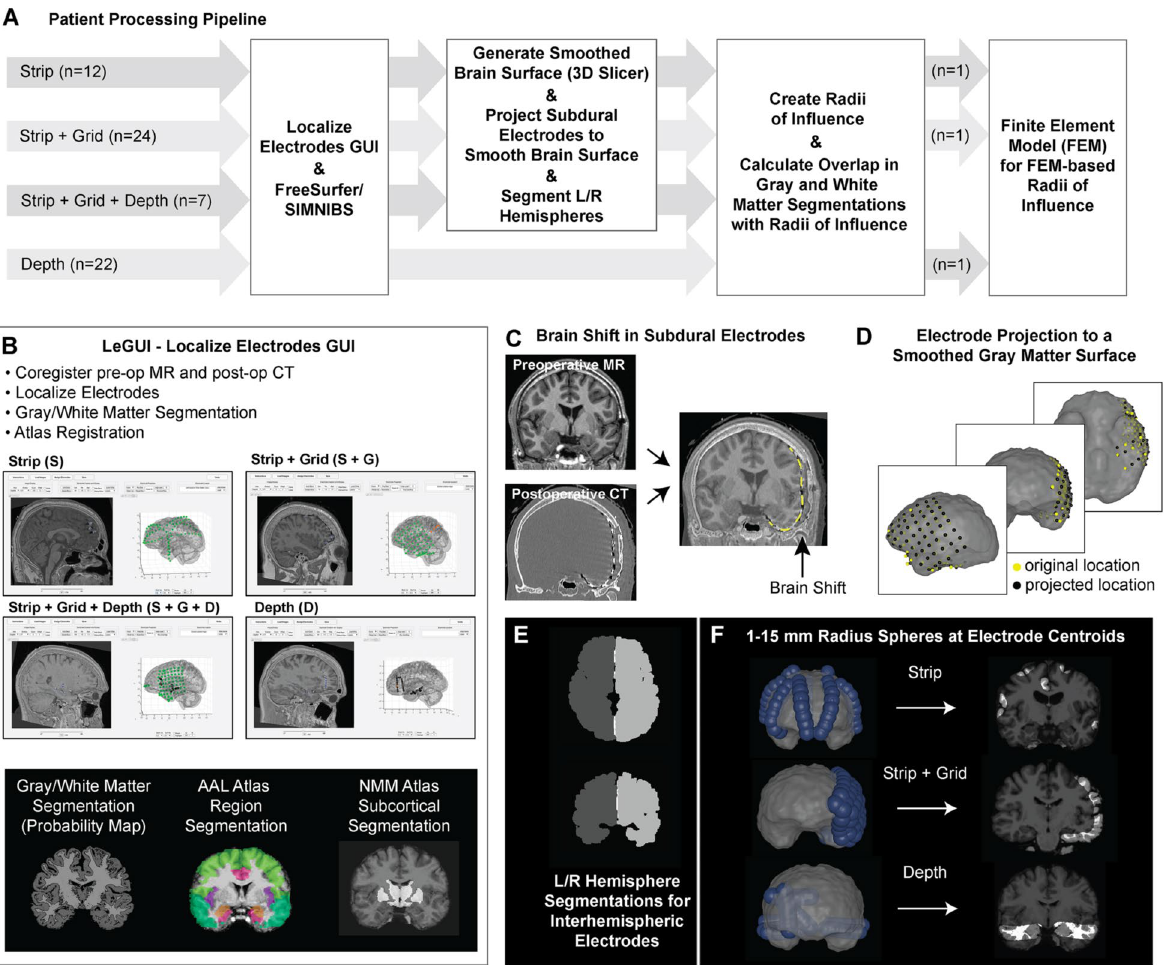
Figure 1. Overview of Methods. ( A ) The processing pipeline used patient specific imaging. All patients were processed through LeGUI, FreeSurfer, and SIMNIBS, while only surface electrode patients received extra processing to project the electrodes to the smoothed gray matter surface as well as left and right hemisphere segmentation for interhemispheric contacts. Overlap of gray and white matter segmentations with RoIs were used to calculate volumes of gray and white matter coverage. A subset of patients were used to run FEM-based RoIs. Reported sample sizes indicate the number of patients included in each implant category. ( B ) Electrode localization was performed in the freely available LeGUI software to mark strip, grid, and depth electrodes across a cohort of 65 patients. LeGUI automatically processes probabilistic gray and white matter segmentations and numerous atlas registrations including the AAL and NMM atlases. ( C ) Substantial brain shift is frequently observed in subdural electrode cases during surgical implantation. After image co-registration, the subdural electrodes localized from the CT may appear inside of the brain (yellow) rather than on top of the cortical surface. ( D ) All subdural electrodes were projected (yellow—original location, black—projected location) onto the smooth gray matter surface according to Hermes et al., 2010. ( E ) In patients with interhemispheric subdural electrodes, the left and right hemisphere segmentations were created in FreeSurfer so that volumes would be restricted to the hemisphere from which the electrode recorded neural activity. ( F ) Spheres at fixed radii from 1–15 mm at 0.5 mm steps were placed at the contact centroids. 10 mm RoIs are shown in blue. Overlap of spherical volumes with gray and white matter segmentations quantify the amount of gray and white matter coverage for different